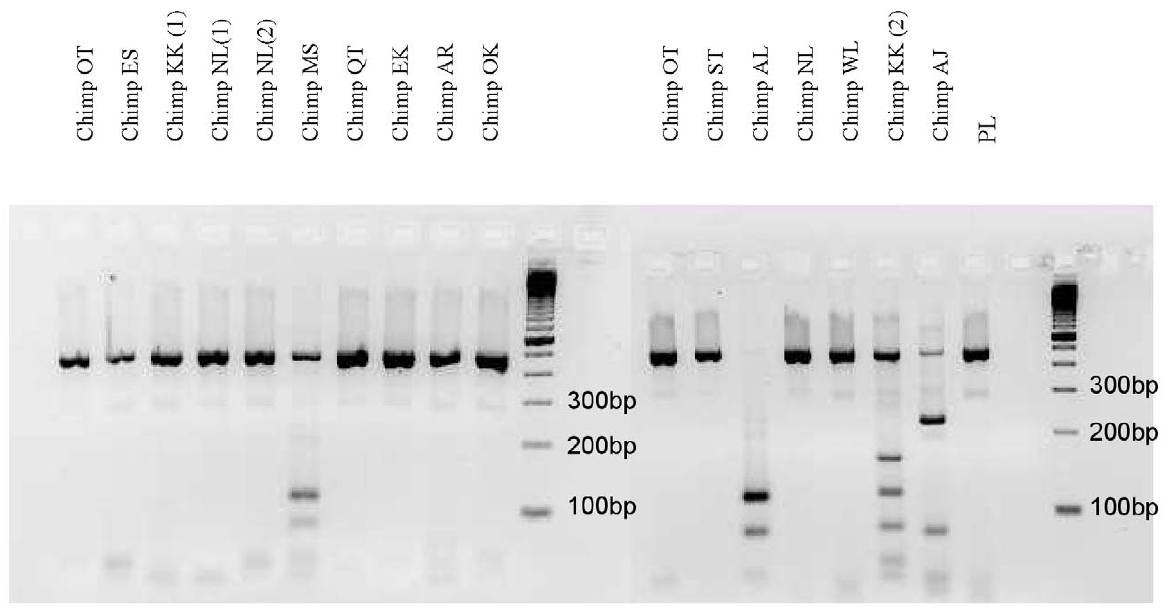
Figure 1. PCR-RFLP of ITS2 using the endonuclease Nla III of DNA samples of Oesophagostomumstephanostomum (chimpanzees MS and AL) and Oesophagostomumbifurcum (chimpanzee AJ) extracted from coprocultured feces of 13 wild chimpanzees. The 13 chimpanzees sampled are: AJ, male, 31 yr old; AL, female, 23 yr old; BB, male, 39 yr old; KK, male, 20 yrs-old; MS male 26 yr old; OG, male, 4 yr old; OM, female 1 yr old; OK, female, 11 yr old; OU, female, 26 yr old; OT, female, 7 yr old; PG, male 17 yr old; ST, male, 50 yr old; WL, female, 13 yr old. DNA from 16 samples of these chimpanzees was extracted and digested. 2 different samples from NL and from KK were analysed, one sample from OK has been tested twice. PCR products at 500 bp correspond to DNA from Panagrolaimus sp. and PCR product of the sample KK (2) to Necator -like DNA species. Control with Panagrolaimus larva (PL).